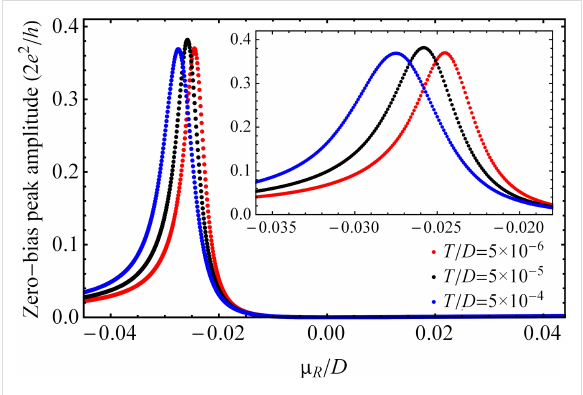
Figure 7: Amplitude of the zero-bias peak as a function of the chemi- cal potential μ R for eV = 0 at three different temperatures and in the absence of a magnetic field. The remaining parameters are the same as those in Figure 5.